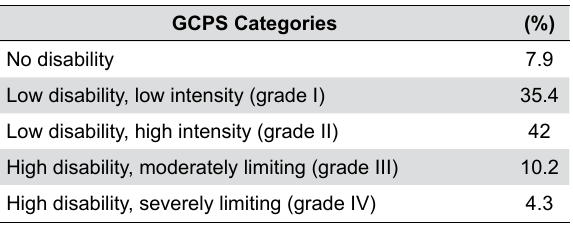
Table 1- Distribution of GCPS ratings